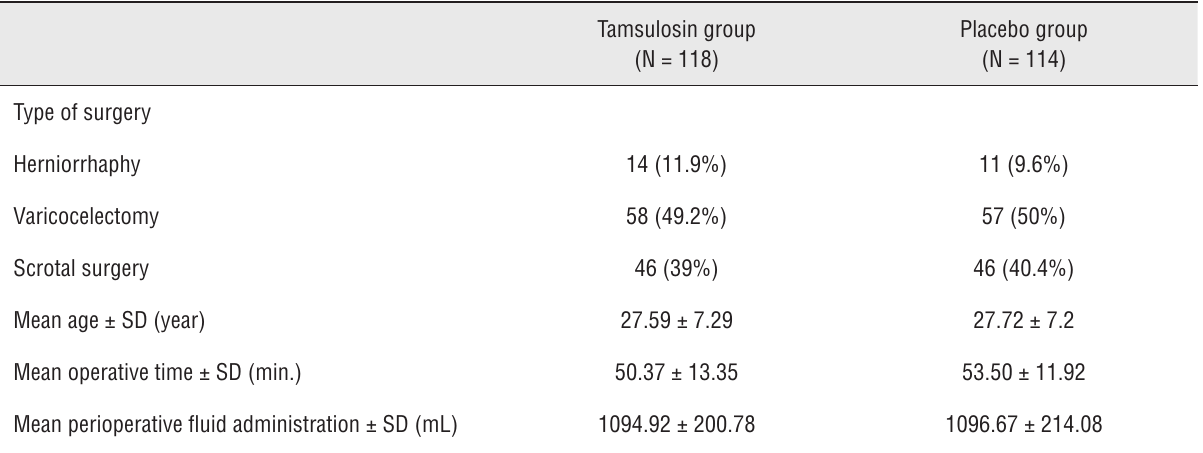
Table 1 - Demographic characteristics and clinical features of patients in both treatment